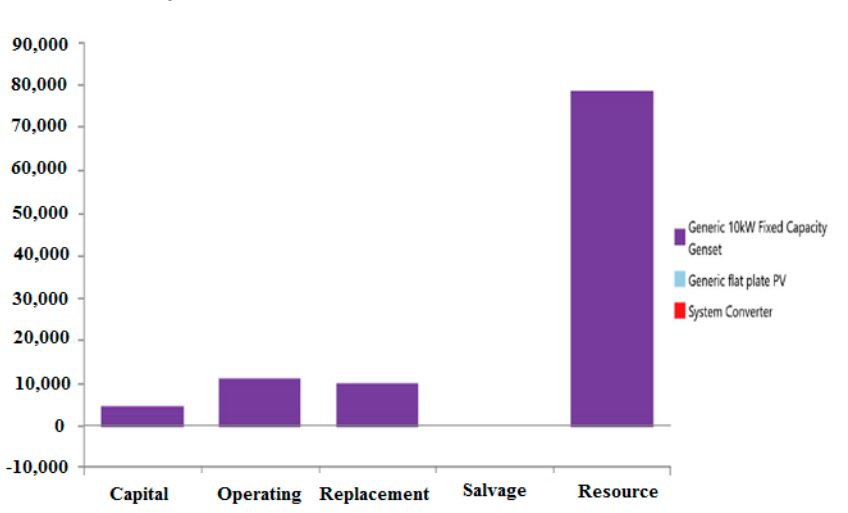
Figure 14. Cost summary of the system (0.8 kW PV).